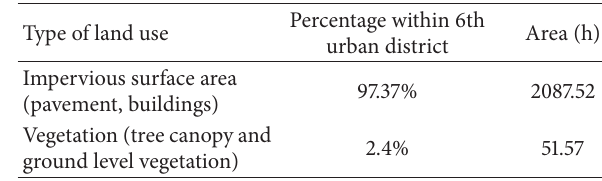
Table 4: Fraction of impervious surface area and vegetation in